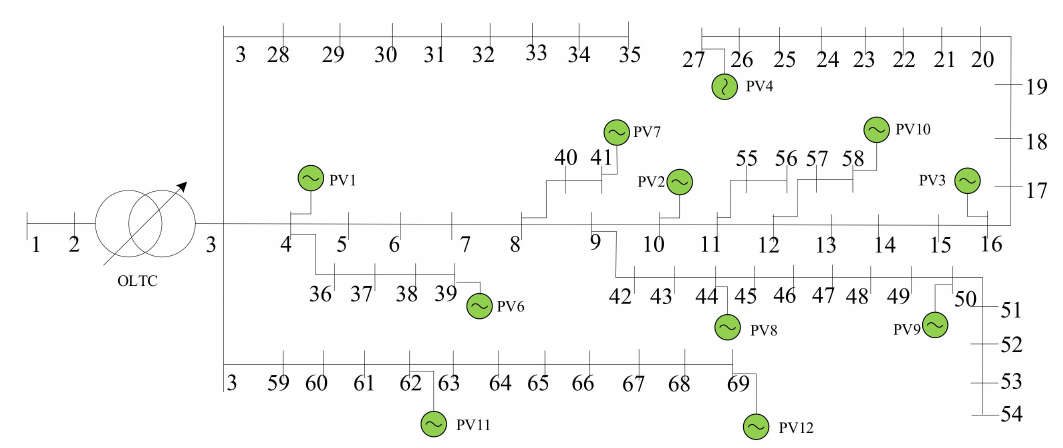
Figure 15. Modified PG&E 69-bus system with uneven PVs.